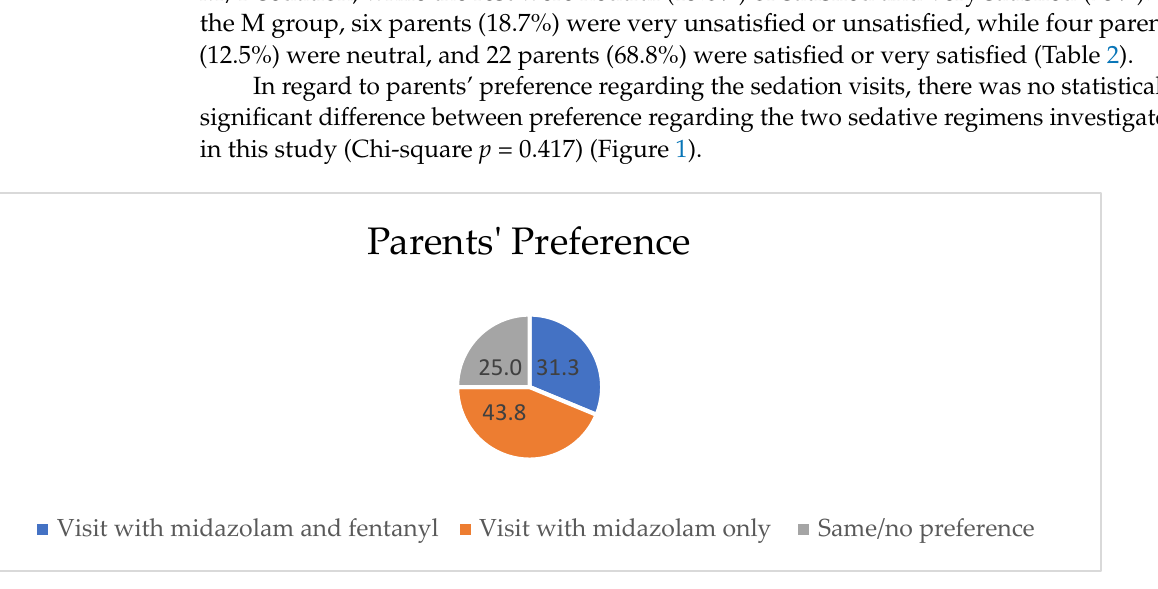
Figure 1. Parents' preference regarding sedation visits. Figure 1. Parents’ preference regarding sedation